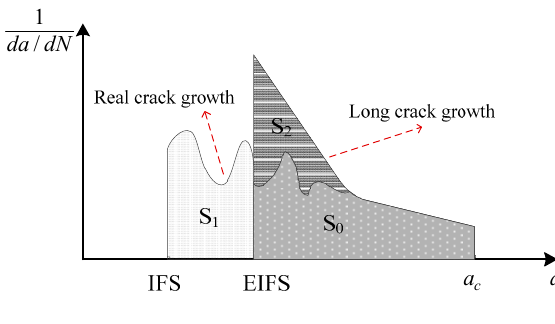
Figure 5. Schematic illustration of EIFS.